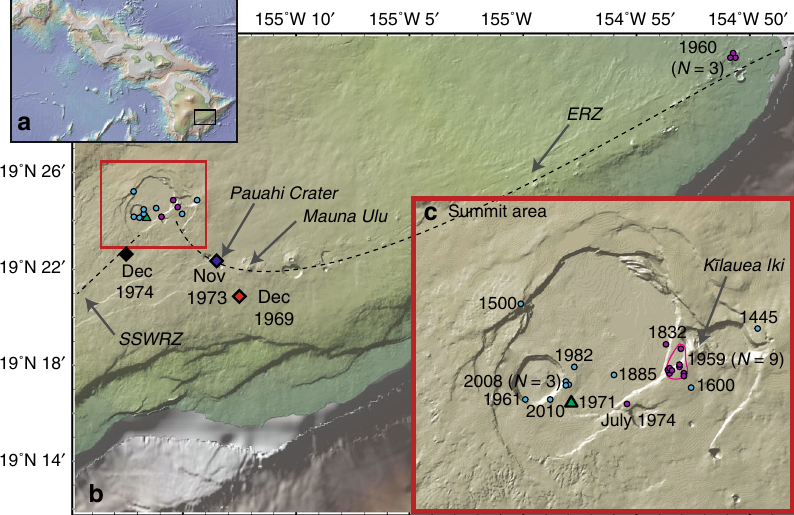
Fig. 1 Sample locations examined in this study and the literature. a Map of the Hawaiian Island Chain, with the black rectangle showing the location of K ī lauea Volcano on the island of Hawai ’ i (expanded in part b ). b Map of K ī lauea Volcano showing the locations of eruptions analysed in this study (bold text), alongside eruptions in the literature with melt inclusion and glass trace element data. Multiple episodes were examined from the 1959, 1960 and 2008 eruptions. K ī lauea ’ s East Rift Zone (ERZ) and Seismic South West Rift Zone (SSWRZ) are shown in dashed black lines. c An expanded map of K ī lauea ’ s summit area (red rectangle in b ). Maps were produced in GeoMapApp (ref. 64 ; http://www.geomapapp.org), and show the topography of K ī lauea before the onset of the 2018 summit collapse. Diamond symbols (red, blue and black) denote eruptions analysed in this study with mean forsterite contents >Fo 84 , while triangular symbols (green) denote the 1971 eruption analysed in this study (mean forsterite content <Fo 84 ). Literature eruptions with mean forsterite contents >Fo 84 and <Fo 84 are shown as magenta and cyan circles respectively (see Table 1).